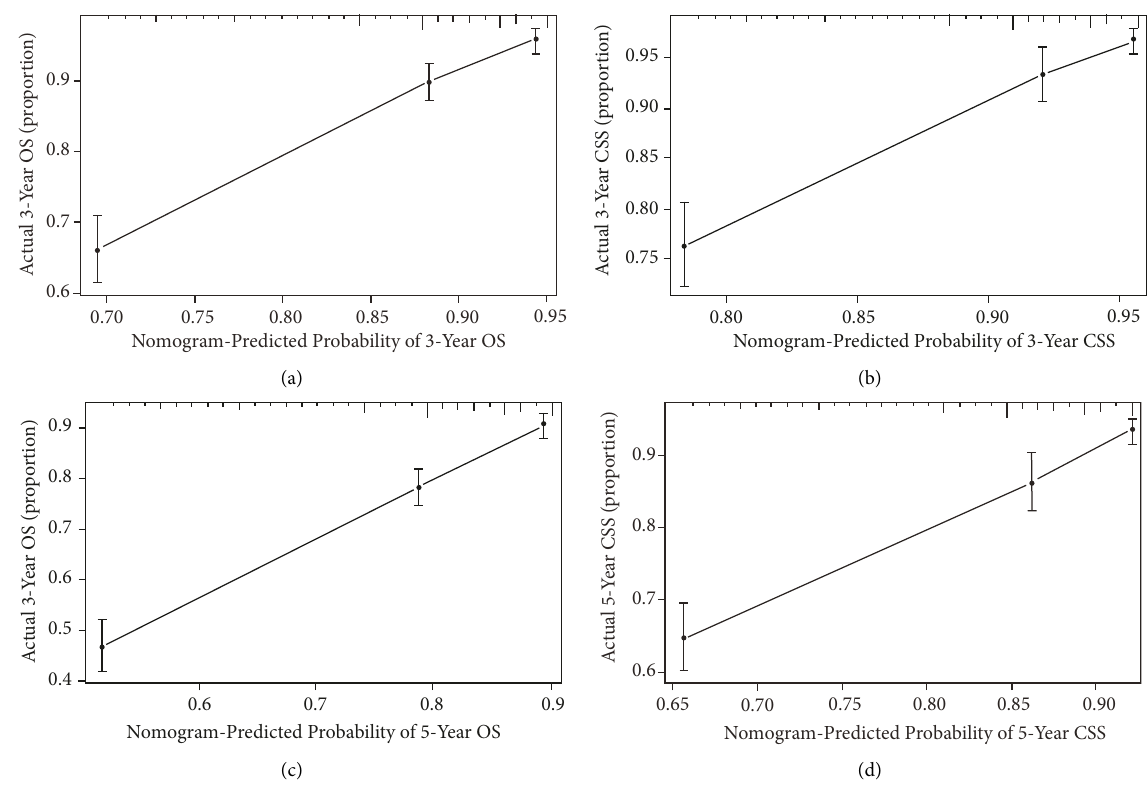
Figure 5: Calibration curves of external validation for predicting 3-year OS (a), 3-year CSS (b), 5-year OS (c), and 5-year CSS (d). OS: overall survival and CSS: cancer-specific